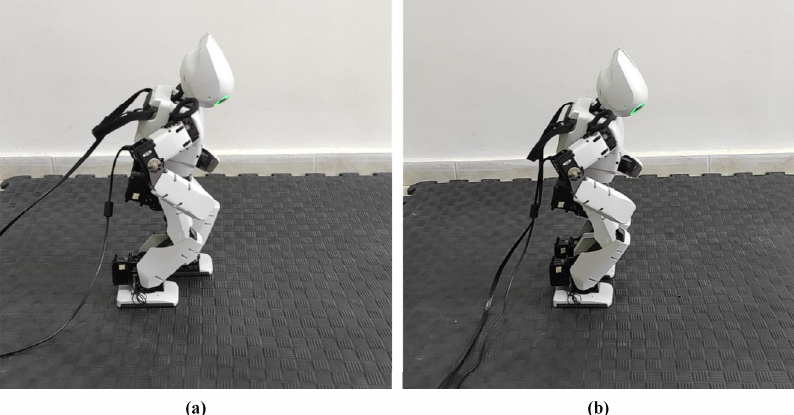
Figure 23. The robot’s initial states of walking: ( a ) proposed framework, ( b ) walking algorithm of robot.